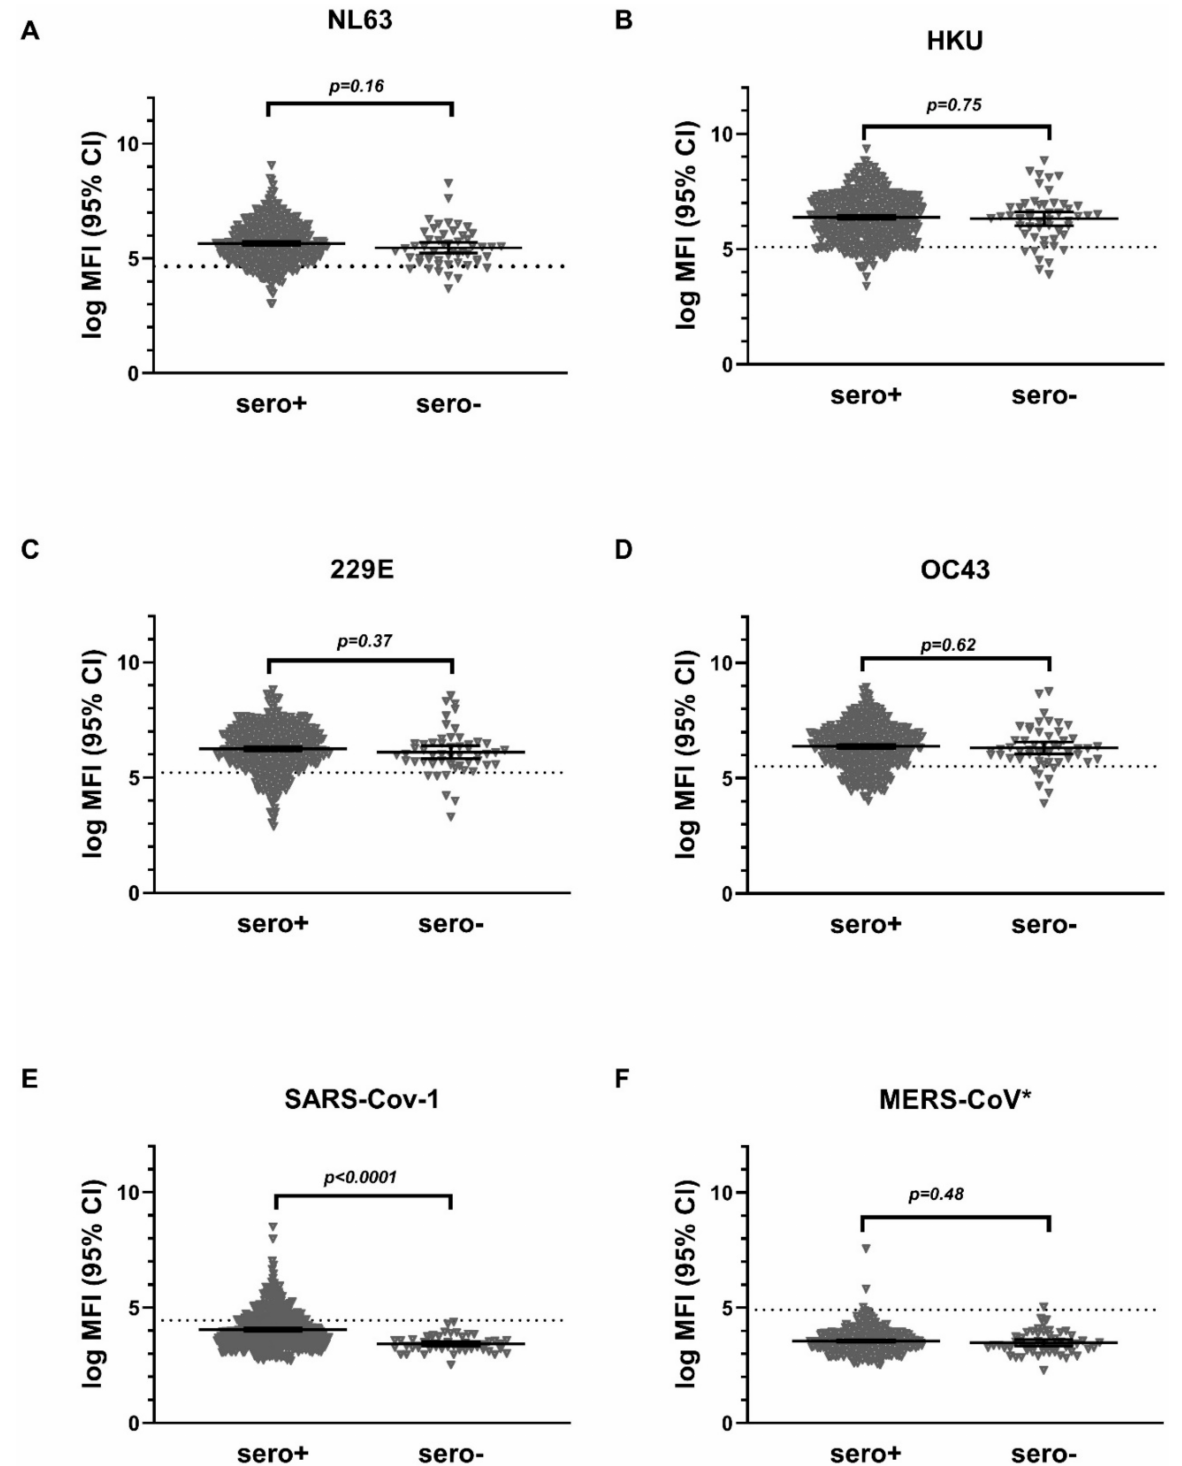
Figure 3. Mean antibody concentration (95% CI) of HCoV (NL 63, HKU, 229E, OC43) ( A – D ), SARS-CoV-1 ( E ), and MERS- CoV ( F ) among SARS-CoV-2 seropositive (Sero+, n = 458) and seronegative samples (Sero-, n = 52). LoG MFI = natural logarithm of mean fluorescence intensity. Sero + = seropositive. Dotted horizontal lines represent cutoff values for positivity for each antigenic target (NL 63 > 4.65, HKU > 5.10, 229E > 5.21, OC43 > 5.52, SARS-CoV-1 > 4.45, MERS-CoV* > 4.91). Two sample t -test was conducted (significance test Wilcoxon signed rank) * Due to a defective low control peptide for MERS-CoV, the cutoff was calculated as mean + 3(SD) of the background